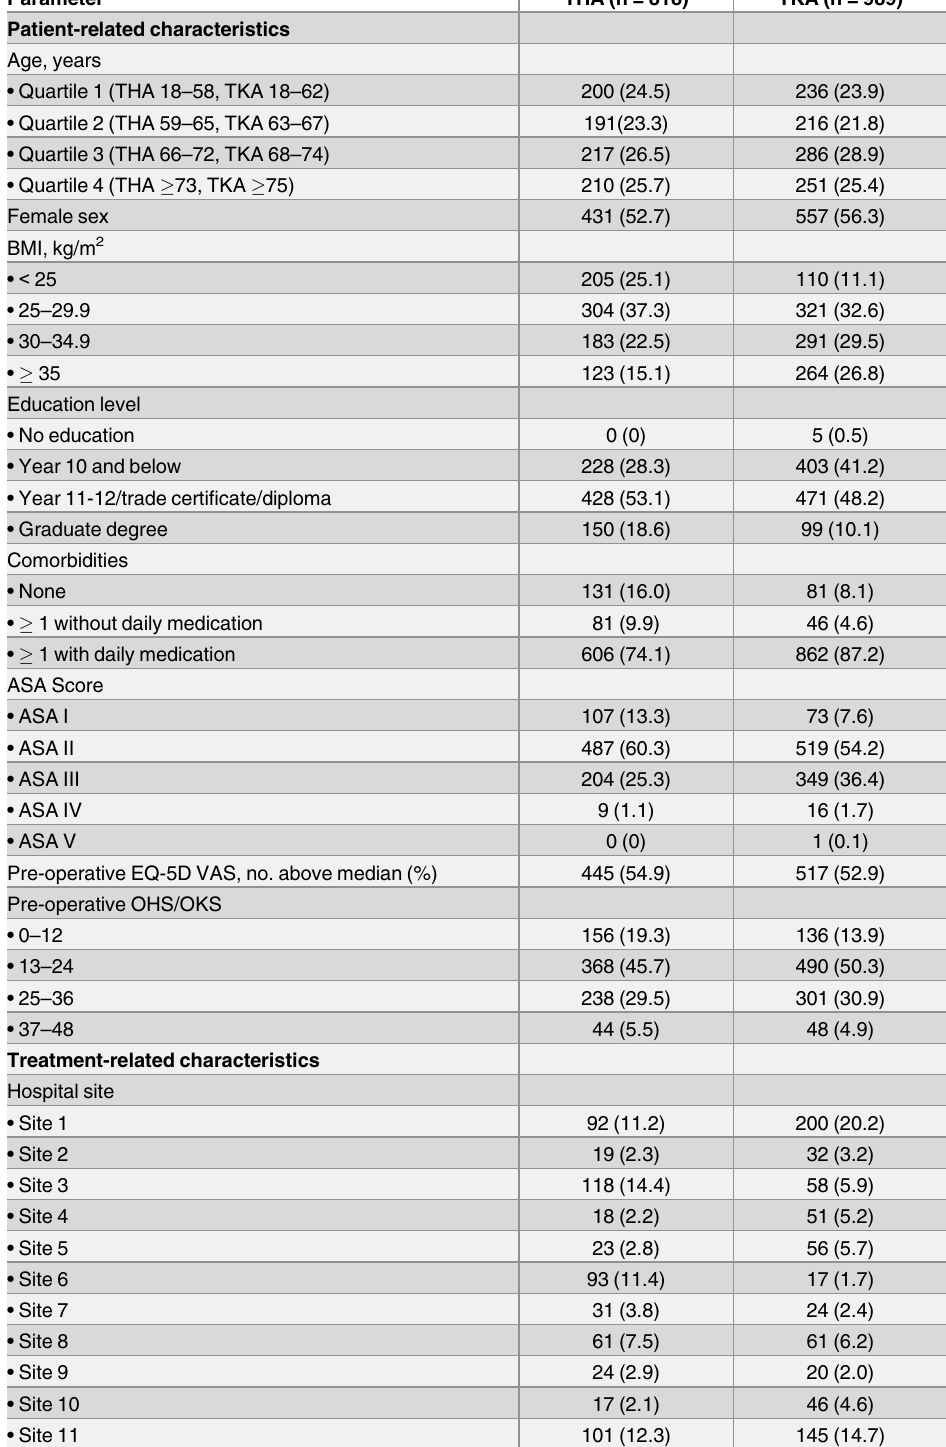
Table 1. Distribution of patient- and treatment-related characteristics of THA and TKA patients. Val- ues are presentedas N (%) unless